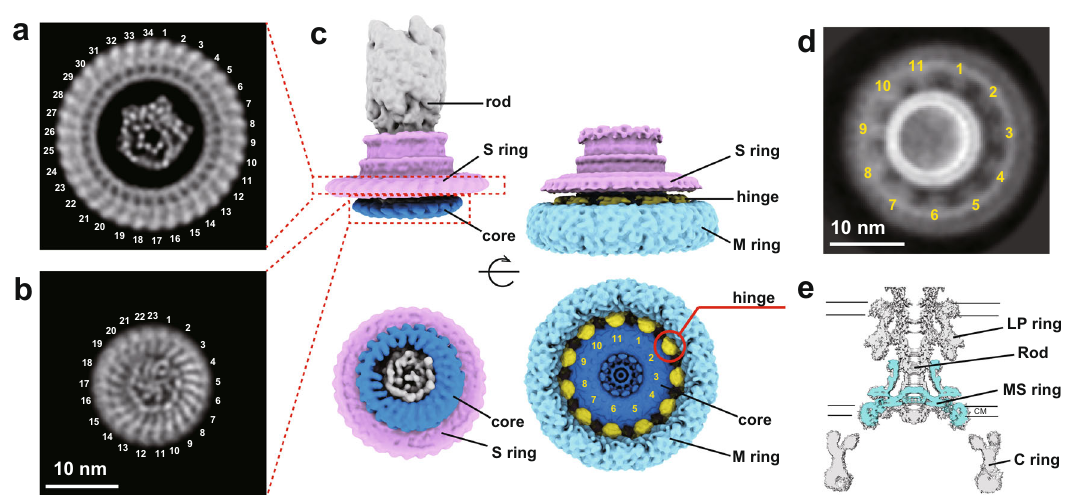
Fig. 4 CryoEM structure of the 34-subunits MS ring with 23-fold and 11-fold subsymmetries. a , b End-on views of the S ring ( a ) and inner part of the M ring ( b ) of the basal body, showing the 34-fold and 23-fold rotational symmetries, respectively. The dot- and rod-like densities at the center of the rings represent the structure of the type III protein export gate formed by FliP, FliQ, and FliR. c 3D reconstructions of the basal body (left) and the MS ring formed by full-length FliF (right) in side (upper) and end-on (lower) views. d 2D class average image of the MS ring in end-on view, revealing the 11-fold rotational symmetry in the M ring. e A central section of the MS ring density through the axis (blue) is well superimposed on that of the basal body density, indicating the structural identity of the MS ring formed by full-length FliF with that of the basal